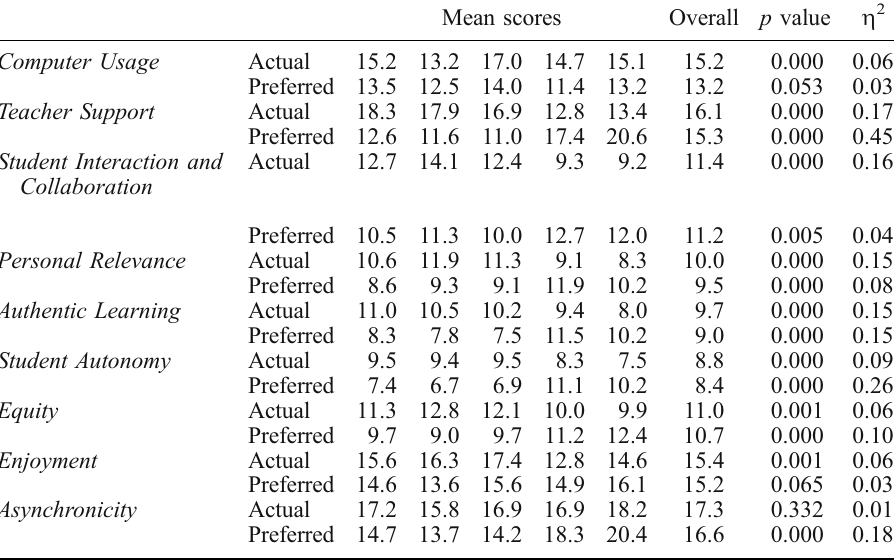
Table 5. OLES subscales tabulated against